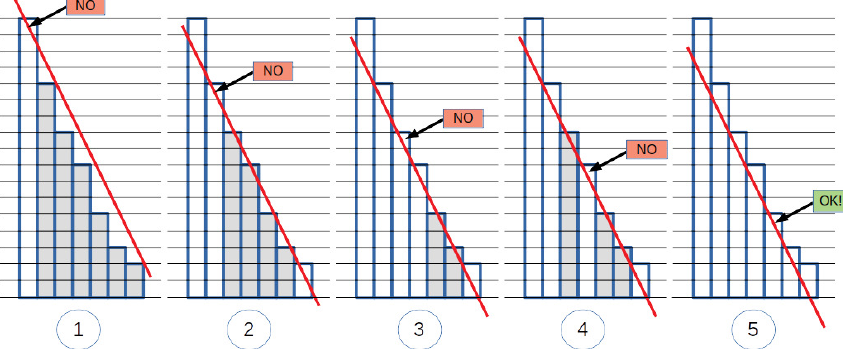
Figure 2. Steps of the geometric cutpoint assessment